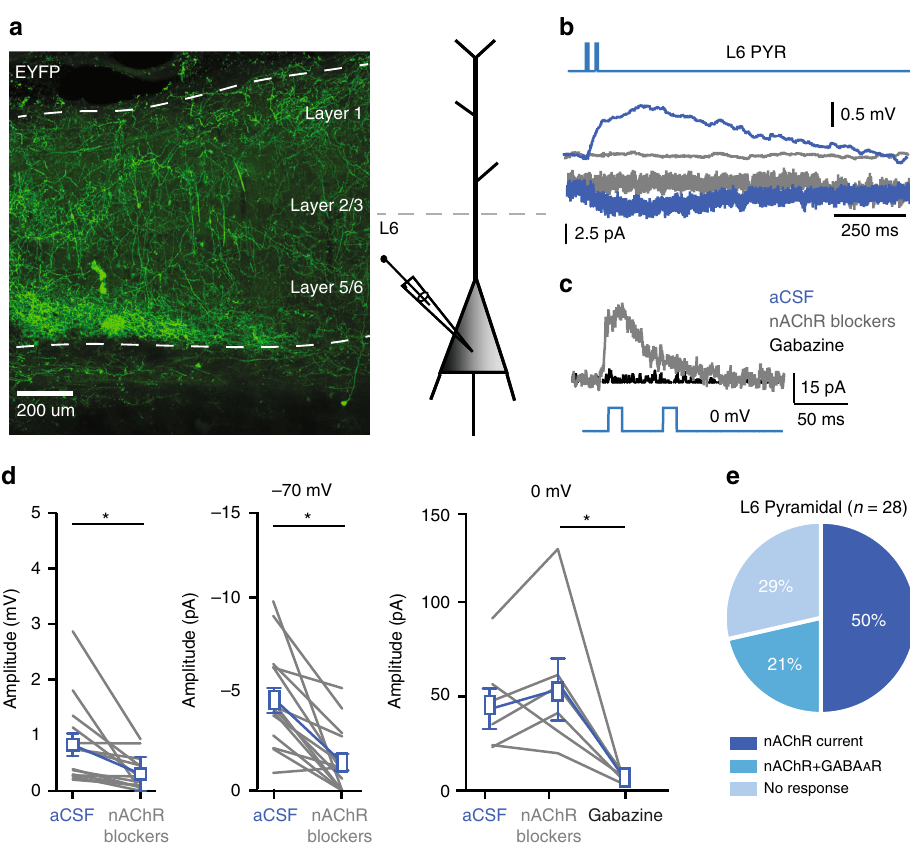
Fig. 4 Direct synaptic inputs to L6 pyramidal neurons. a EYFP expression in ChAT-VIP neurons throughout mPFC layers. Right: schematic illustration of recording set up. b Example traces from a rat L6 pyramidal neuron showing depolarization and an inward current at − 70 mV in response to blue-light ChR2-mediated activation of ChAT-VIP neurons (470 nm, 10 ms, 25 Hz) in absence (blue trace) or in the presence of nAChR antagonists (grey trace). c Same L6 pyramidal neuron recorded at 0 mV membrane potential showing light-evoked synaptic current in the presence of nAChR blockers (grey trace) and gabazine (black trace). d Left: summary chart showing the amplitudes of postsynaptic membrane potential changes with and without nAChR blockers. Middle: postsynaptic current amplitudes at − 70 mV membrane potential without and with nAChR blockers (aCSF: 4.820± 0.6853 pA, nAChR blockers: 1.483 ± 0.4594pA, p = 0.0002, paired t -test, two-tailed, t = 5.051, df = 13; n = 14, mean ± SEM). Right: postsynaptic current amplitudes recorded at 0 mV with nAChR blockers and gabazine (aCSF: 40.85 ± 10.35 pA, nAChR blockers: 50.65 ± 15.47 pA, gabazine: 1.403 ± 0.8461 pA, one-way ANOVA: F (5,10) = 2.949, p = 0.0148; n = 6, mean ± SEM). Summary plots show averages ± SEM. e Pie chart showing percentages of L6 pyramidal neurons with nAChR- mediated, combined nAChR and GABA A R-mediated, and no synaptic